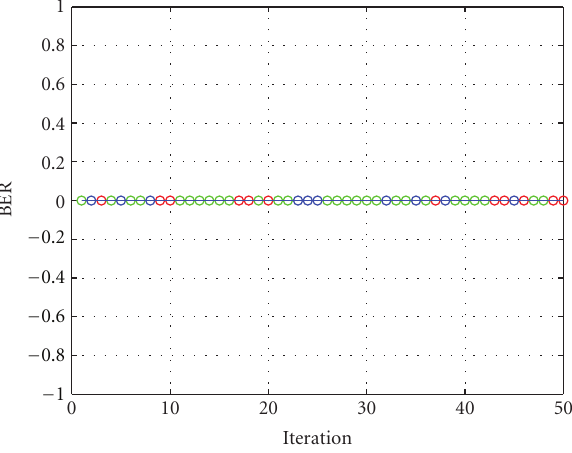
Figure 7: BER of Case I, Case II, and Case III of train-to-train communication model.